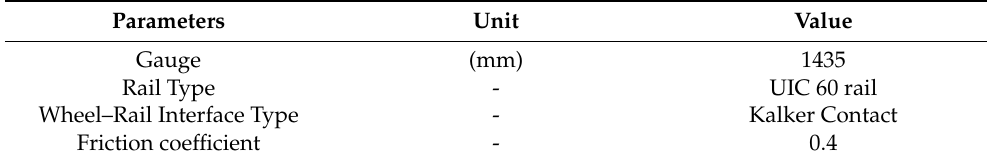
Table 4. Modeling values of track information.